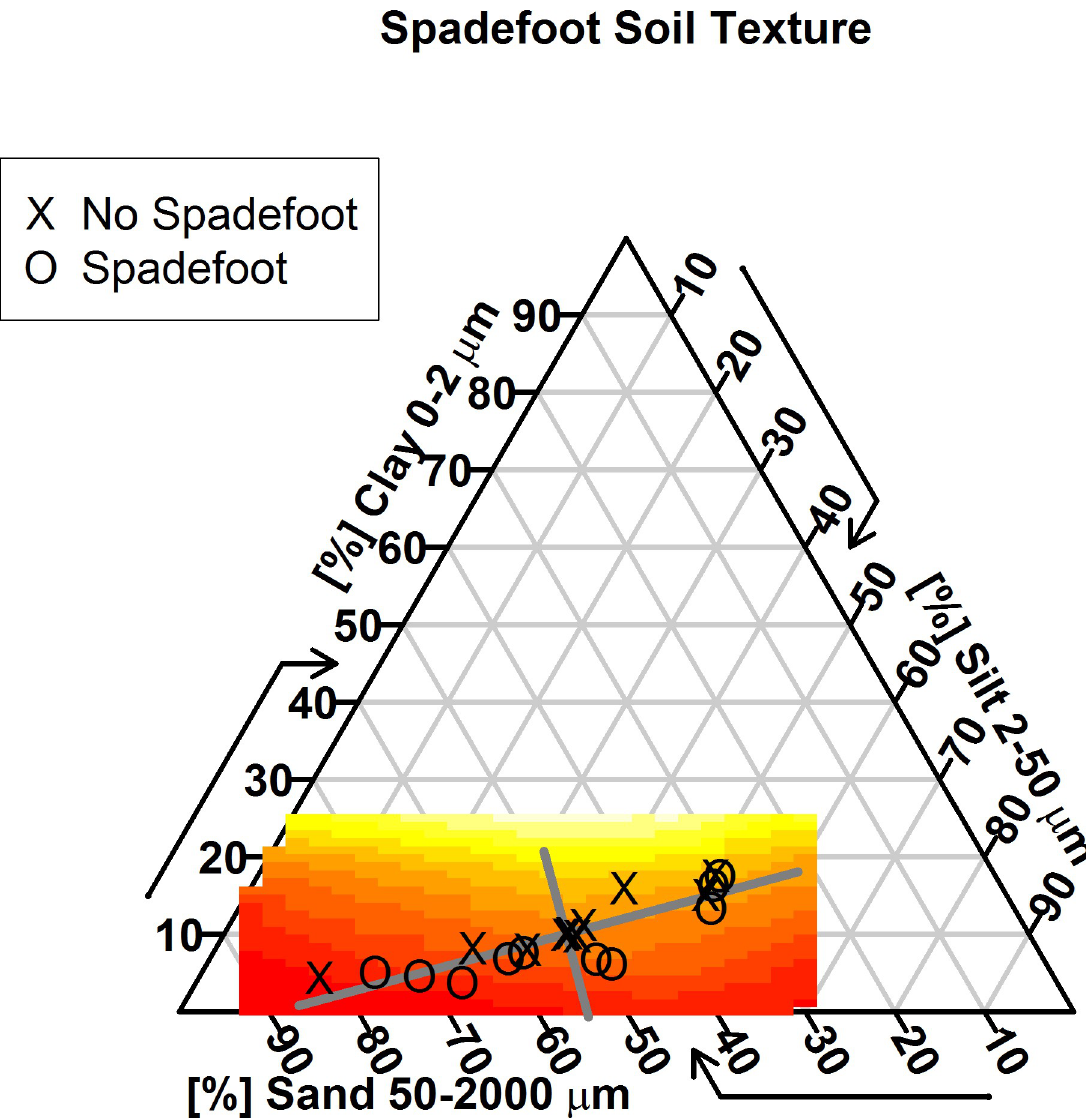
Fig 4. Ternary soil map showing percent composition of clay, sand, and silt at spadefoot sites. On each side the arrow indicates which direction to read for that soil type (e.g. "clay" percentages are read horizontally). Black "X"s indicate the soil texture of pseudoabsence sites and black "O"s indicate soil texture of aestivation sites for our 15 spadefoots. The thick gray lines indicate principal component combinations of soil textures: principal component 1 (longer line) reflects the greatest variation in soil composition in our sites (which spadefoots did not respond to in choosing aestivation sites), and principal component 2 (shorter line) reflects the deviation from the first component (which spadefoots did respond to in choosing aestivation sites). In particular, spadefoots tend to avoid clay soils. In color are model predictions using those two principal components: red signifies 99.7% probability of finding a spadefoot, while light yellow indicates 79.6% probability of finding a spadefoot.